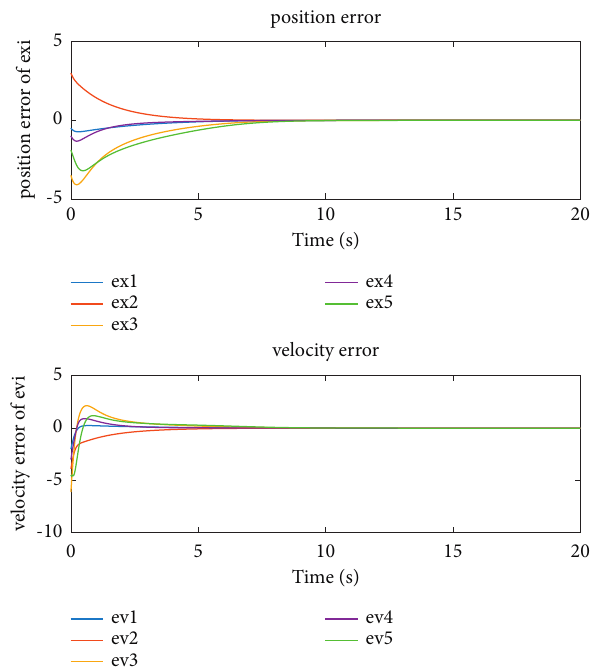
Figure 3: Position error and velocity